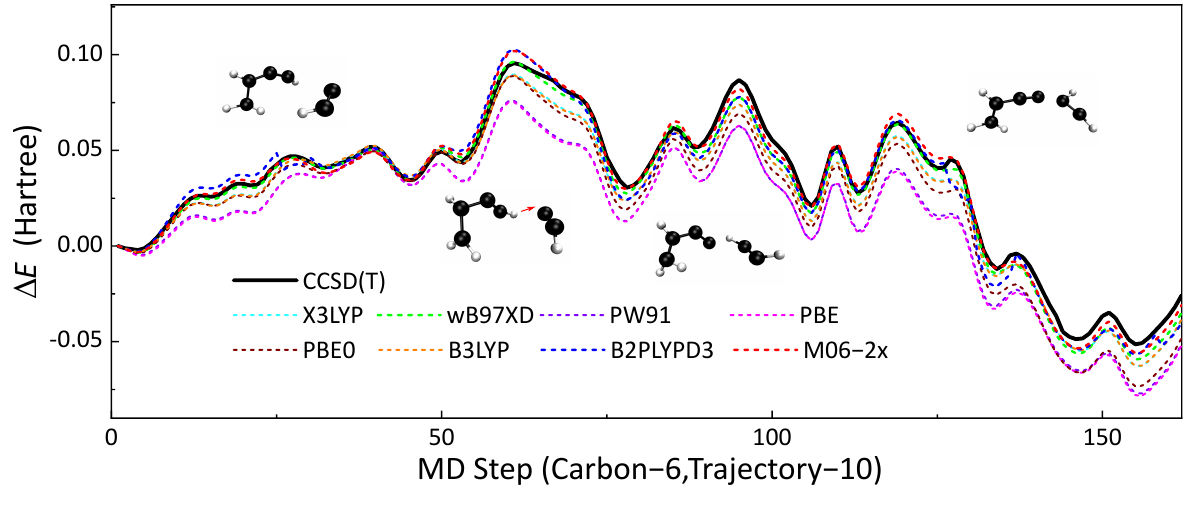
Figure 6. The no. 10 soot trajectory containing six carbon atoms was taken as an example, the profiles of ∆ E with MD times obtained by different DFT methods (dotted line) are shown in this figure, and the results of CCSD(T) (black line) were used as the reference. Each time step of molecular dynamics took 0.5